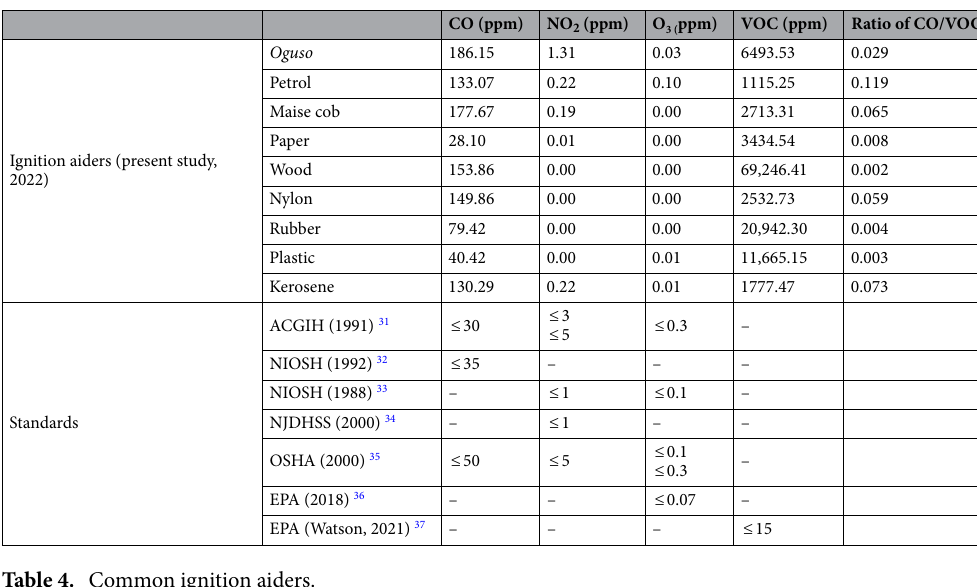
Table 4. Common ignition aiders.